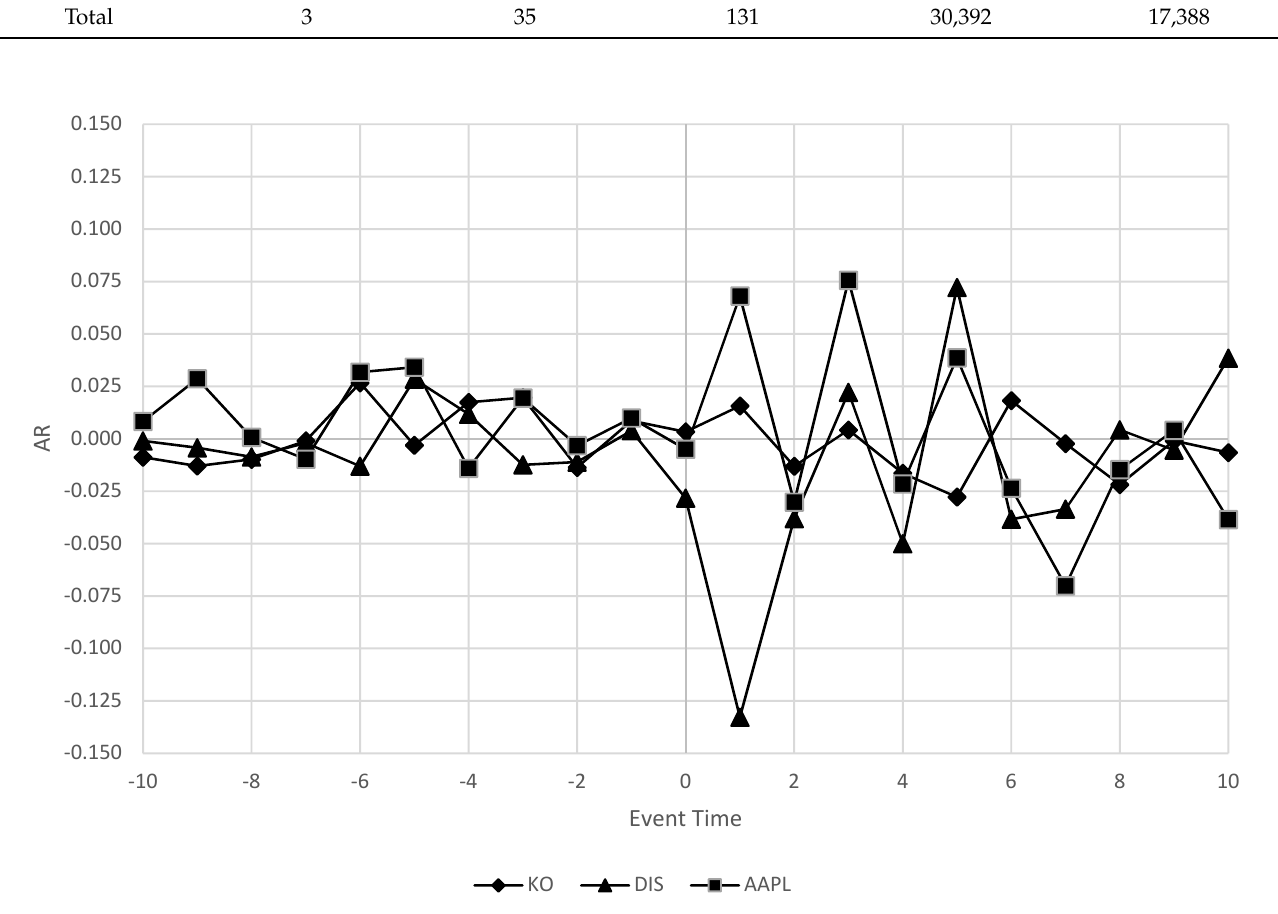
Figure A1. Plot of abnormal returns for the “9/11” Geopolitical event and event window ( − 10,10).